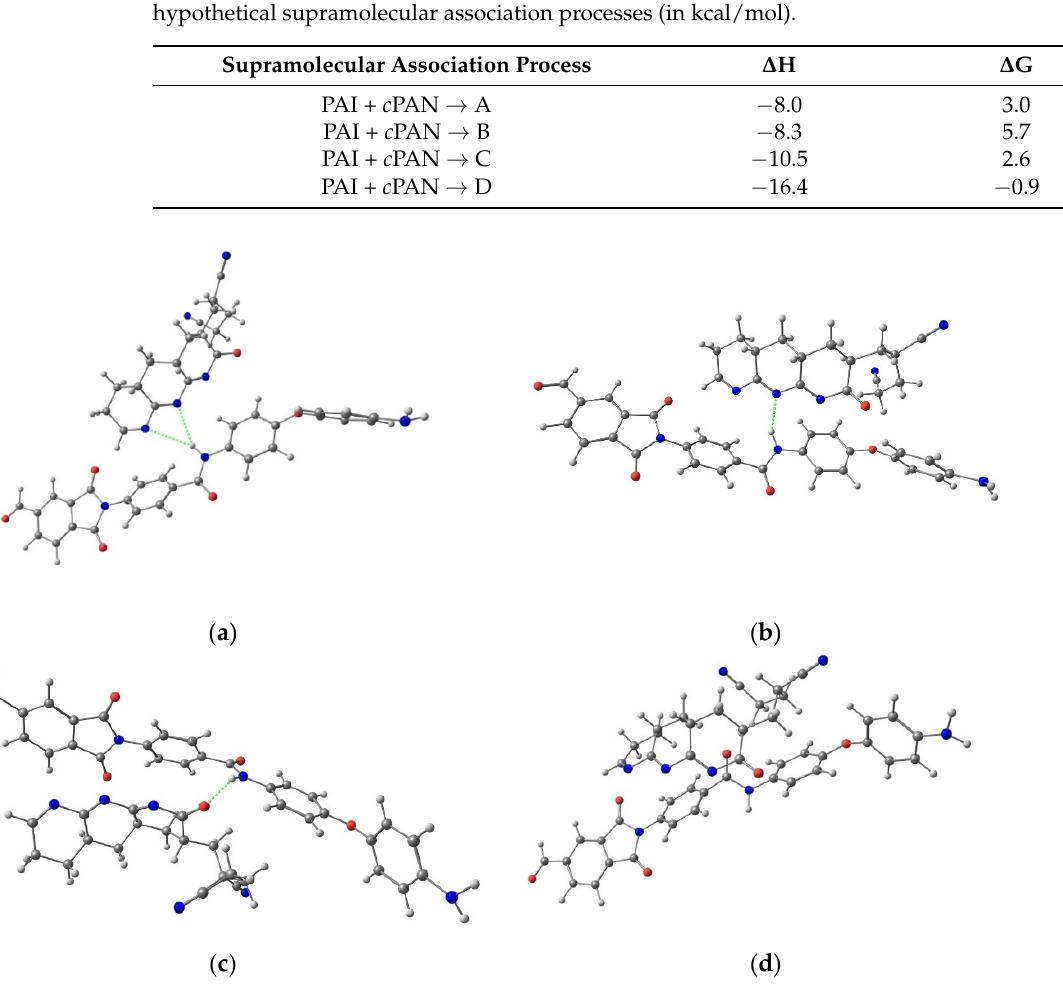
Figure 5. Supramolecular associates ( a ) A, ( b ) B, ( c ) C, and ( d ) D. Scanning electron microscopy (SEM) was used to study the membrane